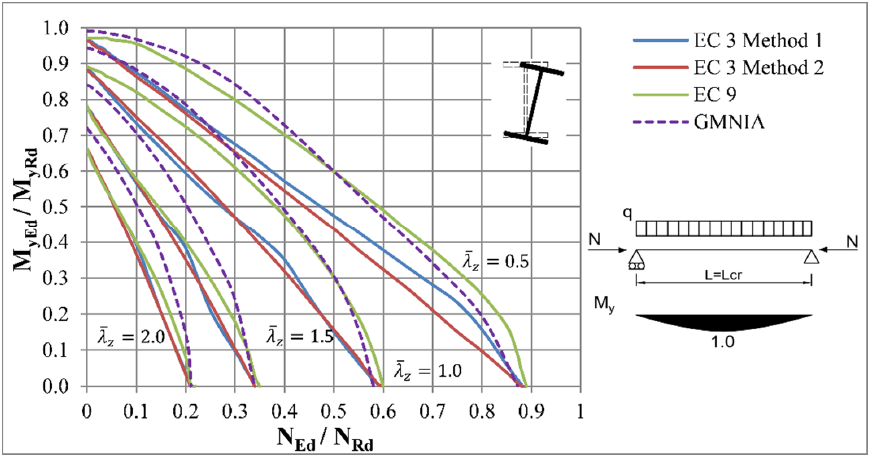
Figure 16. Interaction curves for laterally unrestrained beam-columns with IPE 100 cross-section with restrained warping.